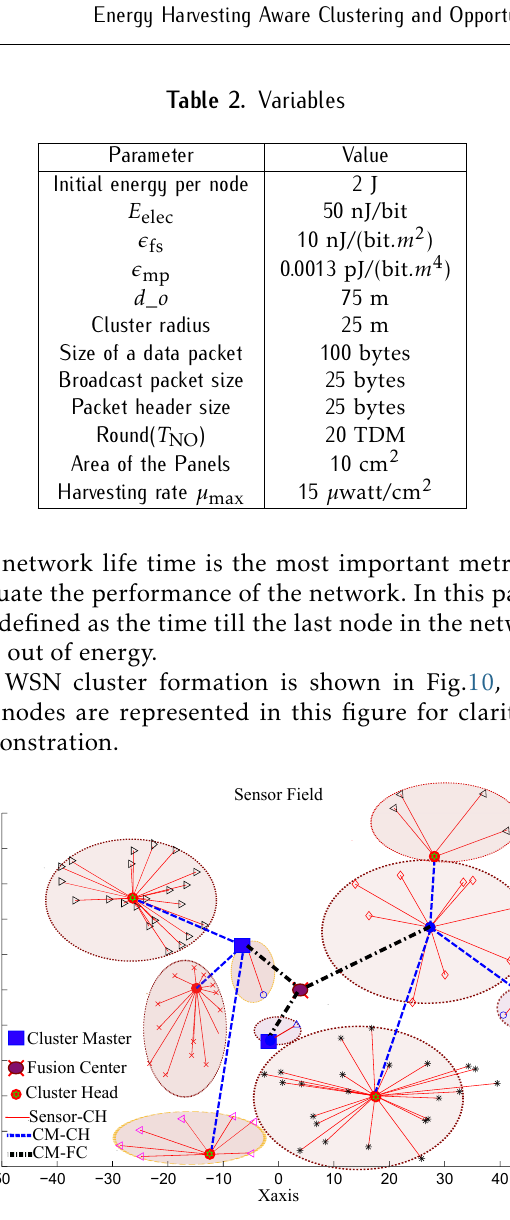
Figure 10. Hierarchal cluster formation for the proposed EHFP clustering scheme